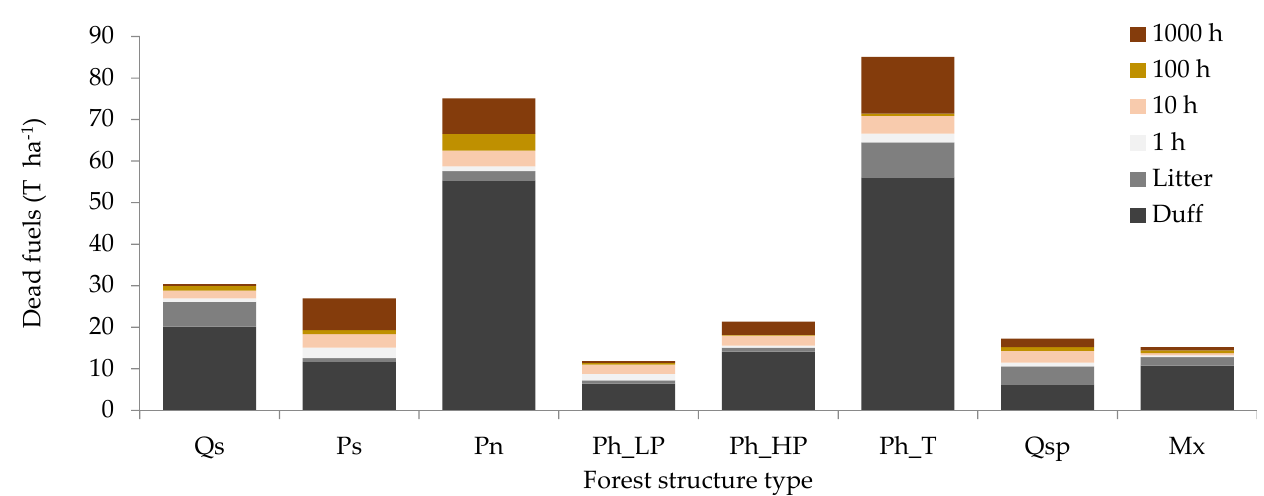
19 of 23 Figure A2. Fire spread model calibration in the different fire modeling domains. Histograms show the fire size distribution for actual (1883 to 2015) and modeled large fires (>100 ha). In planning area 4 ( A ), 29 historical events had a 1244 ha average fire size, and modeled fires had an average fire size of 1216 ha. In planning areas 2 and 3 ( B ), 25 historical events had a 1453 ha average fire size, and the modeled fires 1428 ha. In planning areas 5 and 6 ( C ), 48 historical events had a 780-ha average fire size, and the modeled fires had an average fire size of 779 ha. In planning area 1 ( D ), 29 historical events had a 695-ha average fire size, and the modeled fires had an average fire size of 699 ha. Appendix C. Dead Fuel Loads in Dominant Forest Types Required dry biomass data for assessing the FC was obtained from field sampling campaigns conducted on the dominant forest typologies (Table 1; Figure A2) and complemented with fuel loading data from standard fuel models in herbaceous type models and live woody components [46]. We used different methods to estimate dead fuel loadings for the different fuel fractions. The field sampling combined litter and duff extractions on 30 cm radius circular plots (n = 16 plots per forest structure type) and 1, 10, and 100 h fuel extractions on 2 m square plots (n = 3 per forest structure type). All these